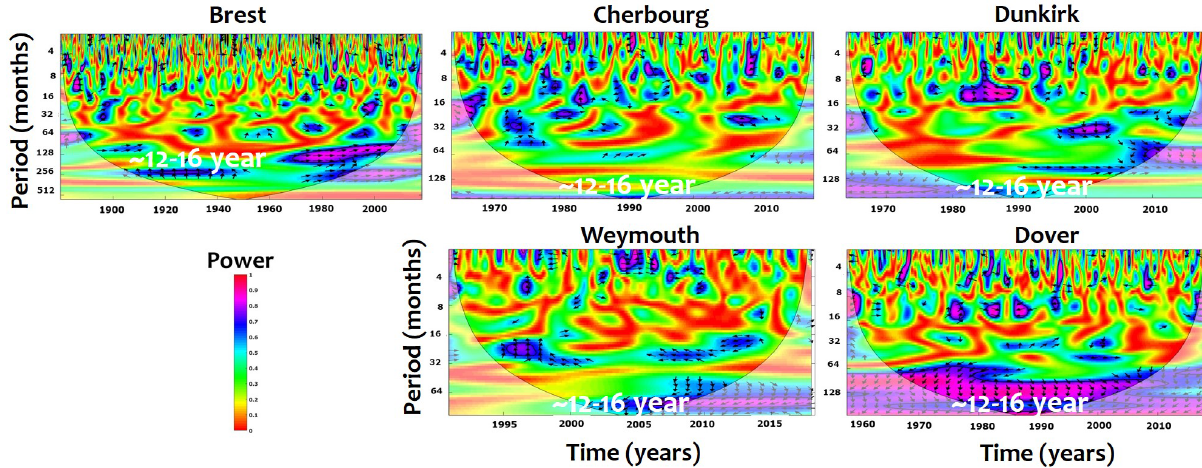
Figure 8. Cross-wavelet correlations between monthly extrema of surges and the Atlantic Multidecadal Oscillation